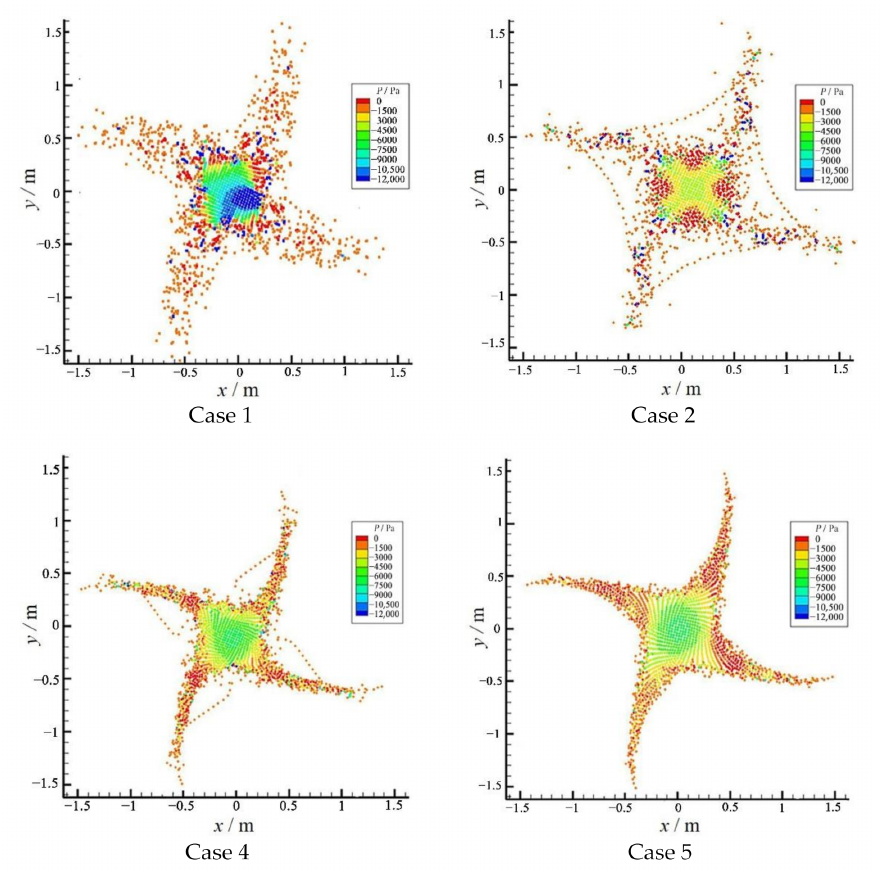
Figure 1. Deforming states at the end of the 2D computation for four cases (particle position and